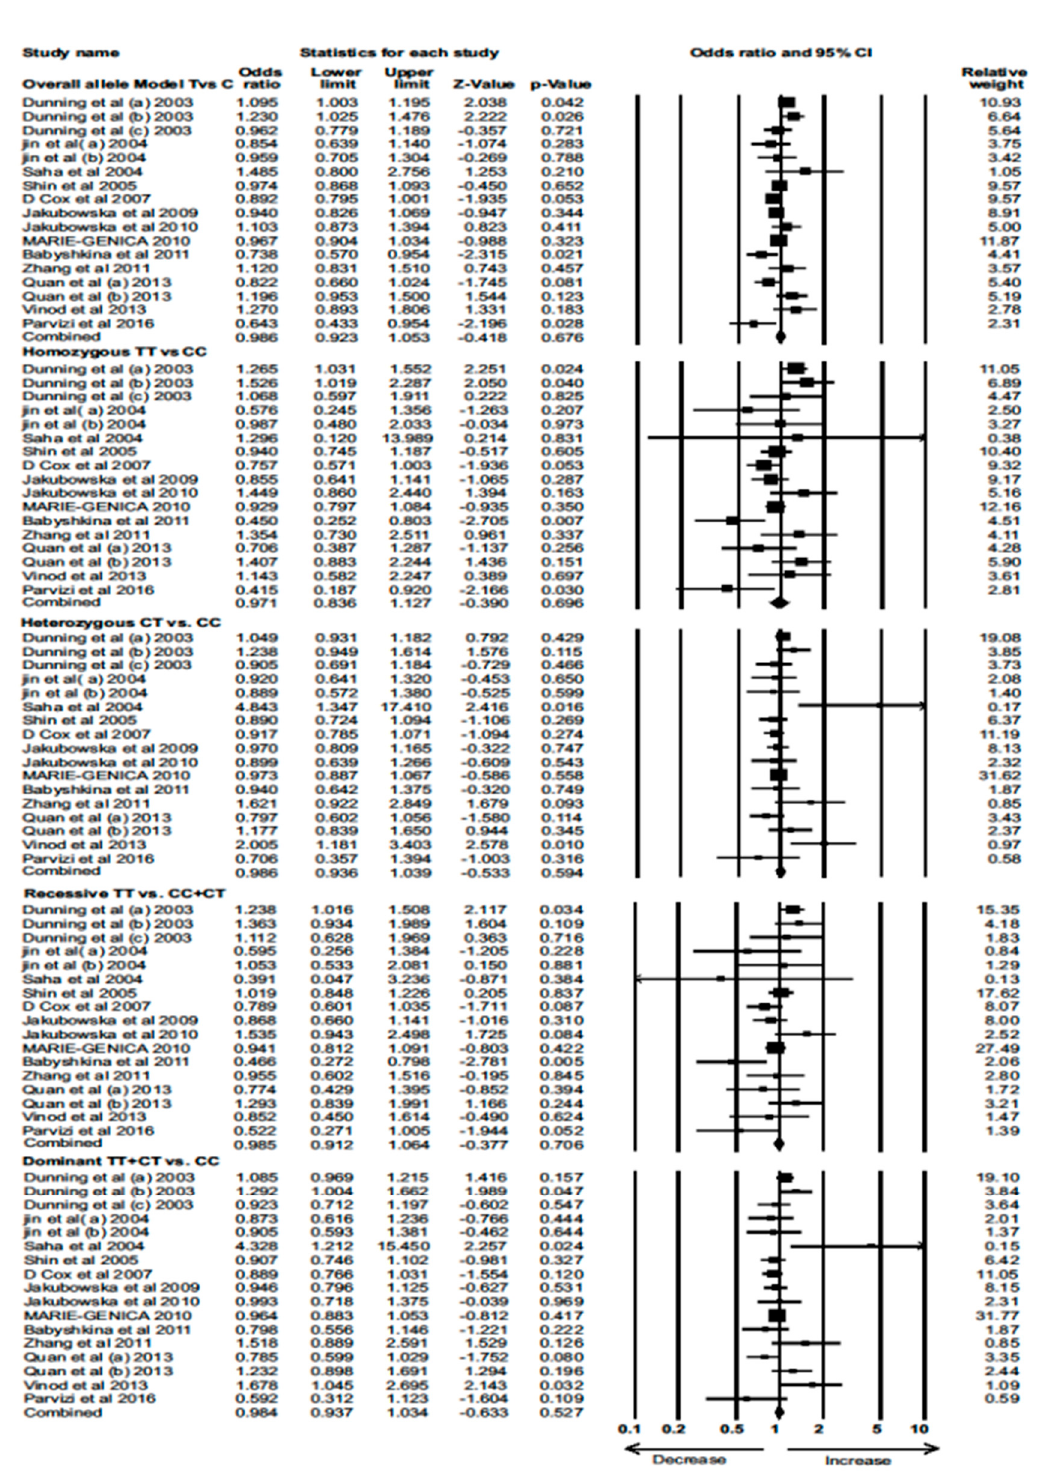
Figure 3. Forest plot of overall allele and genotypic analysis of the TGF- β 1 -509 C / T polymorphism and assessment of its association with BC risk using combined odds ratios (ORs) and 95% confidence intervals (CIs) of the ORs. Black squares represent the ORs of the individual studies, and horizontal lines indicate the 95% CIs of the ORs.